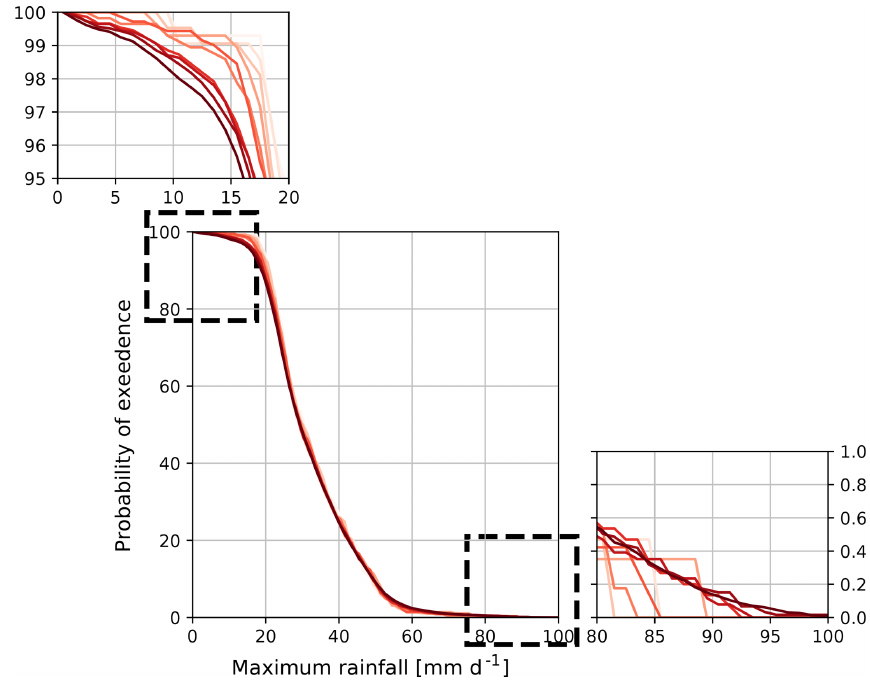
Figure 10. Probability of occurrence of heavy rainfall for different horizontal resolutions. Darker red represents higher horizontal resolution (from 0.1 to 0.01 ◦